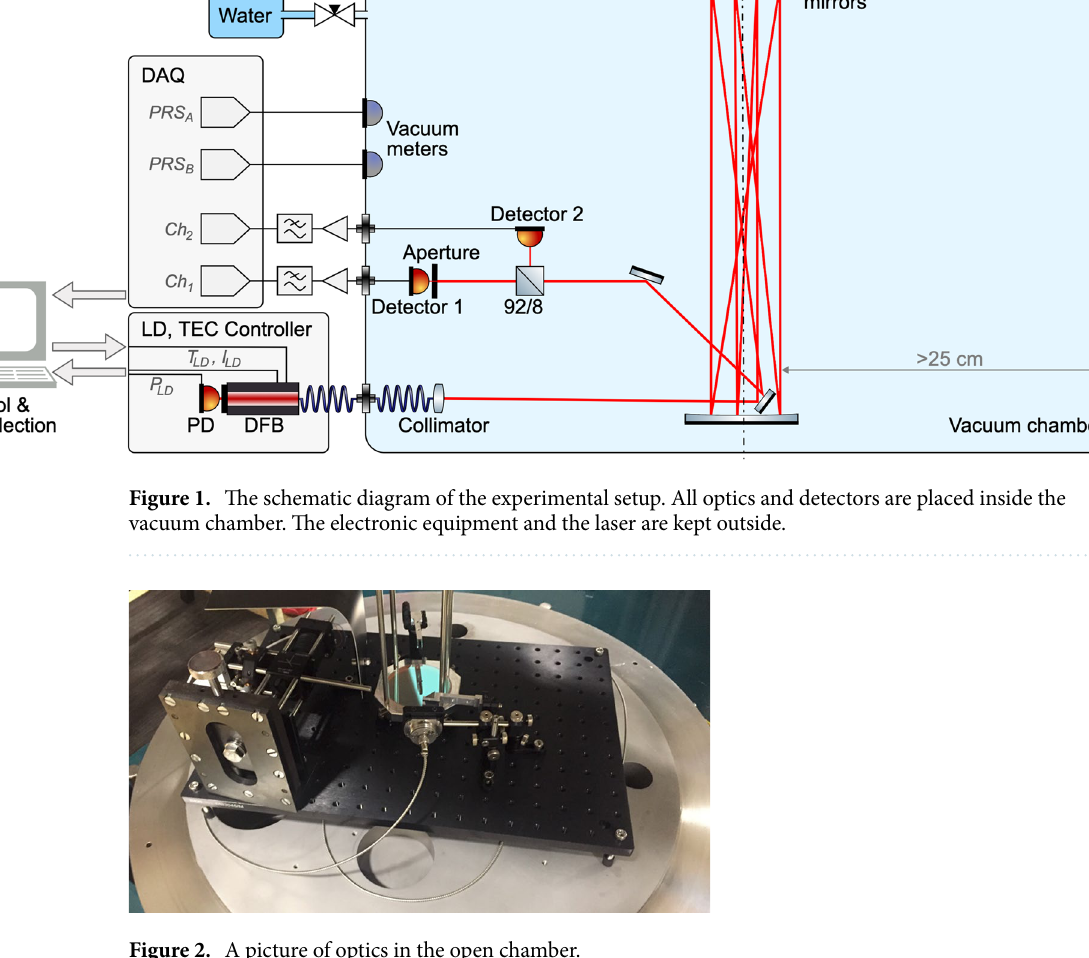
Figure 2. A picture of optics in the open